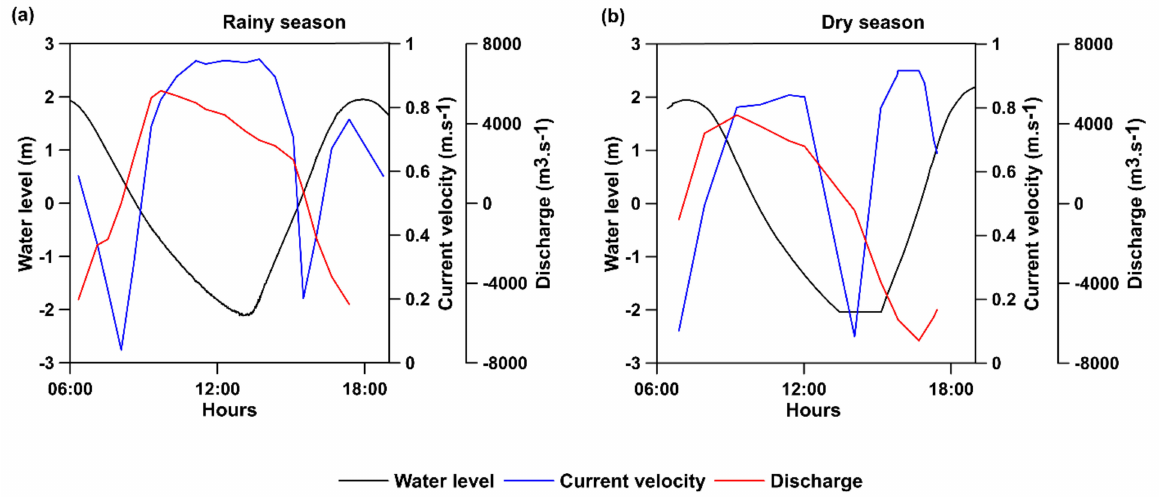
Figure 4. Hydrodynamics in the cross-sectional area comparing the discharge (red line) and the current velocity (blue line), during the rainy ( a ) and dry ( b ) seasons. The black line shows the water level